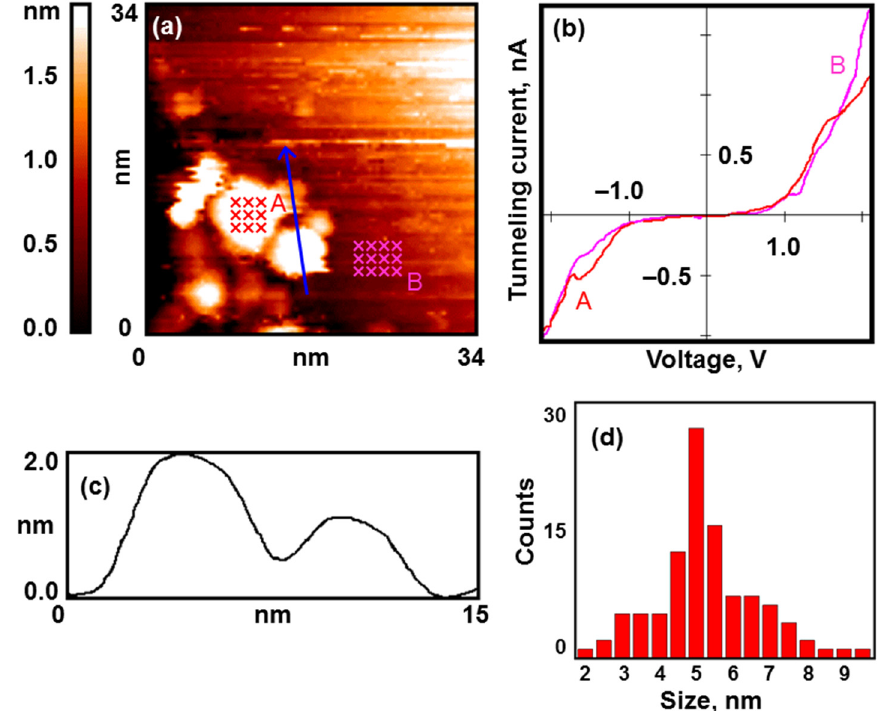
Figure 5. Nanoparticles of nickel after calcination under UHV conditions and reduction in H 2 . Results of the STM/STS measurement: ( a ) topography image of HOPG surface with deposited nickel nanoparticles; ( b ) VAC curves of the tunneling currents averaged over the set of points on the surface of nanoparticle (red curve A) and HOPG (pink curve B) marked with crosses in ( a ); ( c ) profile of the surface along the cut line shown in ( a ); ( d ) size distribution.